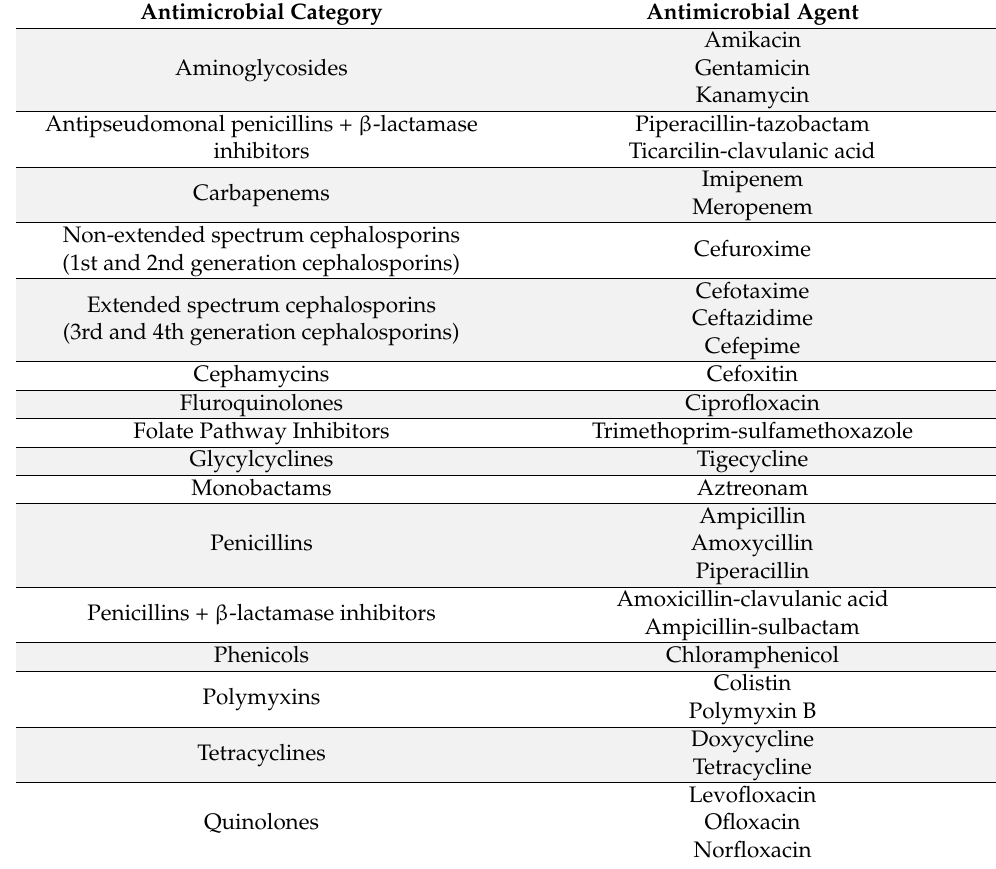
Table 1. Antimicrobial categories and agents used. Antimicrobial